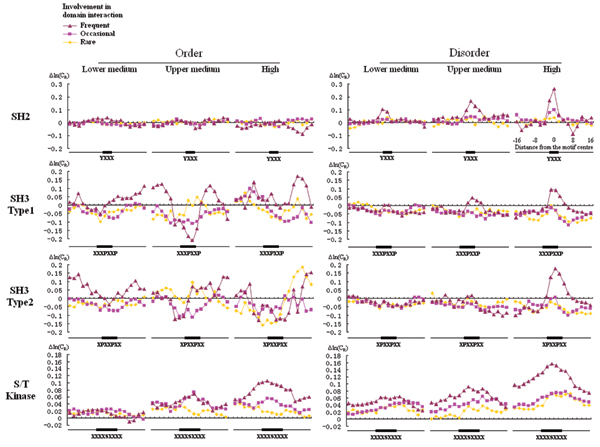
Conservation profiles of Short Linear Motifs (SLiM). Conservation profiles of SLiMs with lower medium, upper medium and high selectivity values for SH2, SH3 and S/T Kinase domains in functional groups that are frequent, occasional or rare interaction partners of each domain.